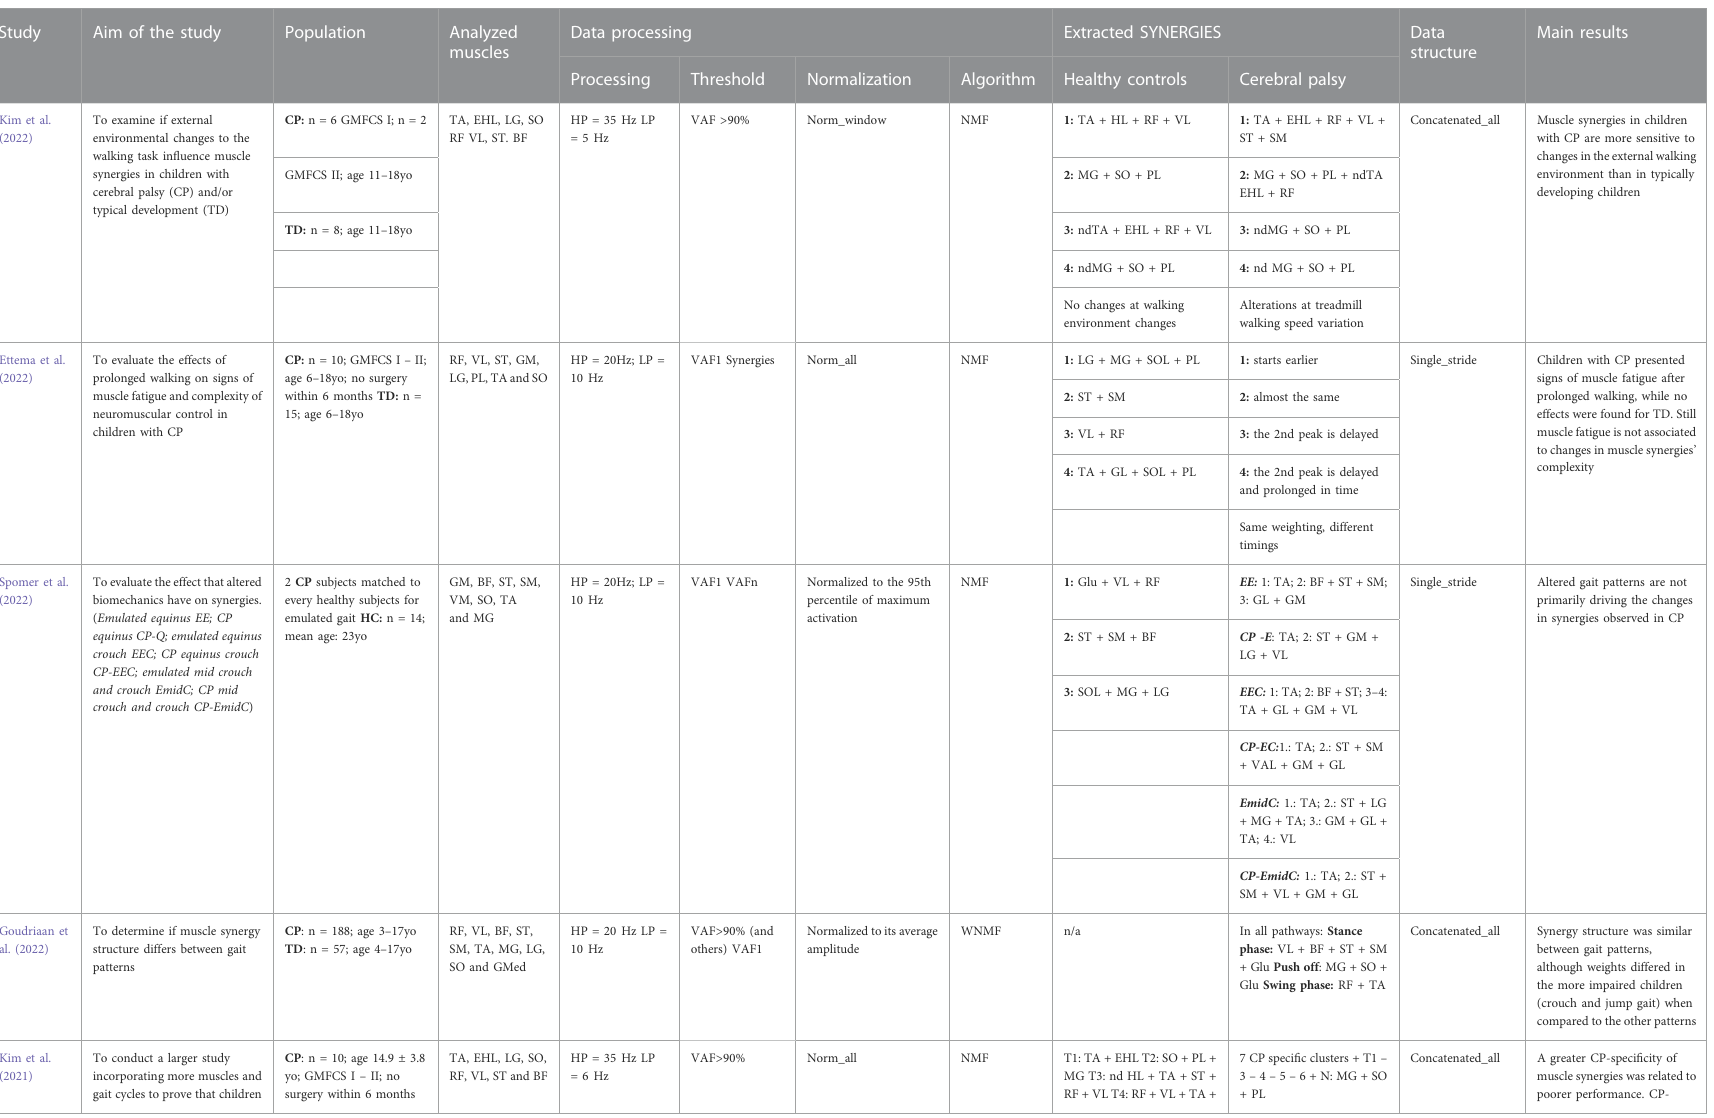
TABLE 1 Aim of the study, population, analyzed muscles, data processing, data structure, extracted synergies, main results of the articles investigating how muscle synergies vary in children affected by Cerebral Palsy (CP) in respect to healthy subjects. Acronyms: CP: cerebral palsy, TD: typically developed, HC: healthy controls, GMFCS: Gross Motor Function Classi fi cation System, BW: backward walking, FW: forward walking, SDR: selective dorsal rhizotomy,BoNT-A:BotulinumToxinType-A,GM:gluteusmaximum;Gmed:Gluteusmedius;BF:bicepsfemoris;ST:semitendinosus;SM:semimebranosus; RF:rectusfemoris;VL:vastuslateralis;VM:vastusmedialis;TA:tibialis anterior;PL:peroneus longus;EHL:extensor hallucislongus;SO:Soleus; ES:erector spinae;TFL;tensor fasciaelatae;MG:medial gastrocnemius;LG:lateralgastrocnemius;